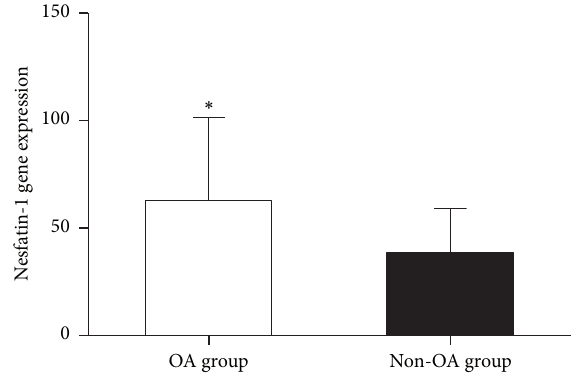
Figure 3: Nesfatin-1 levels in serum (S) and synovial fluid (SF). Serum nesfatin-1 levels were significantly higher in patients with OA than in controls ( ∗ 𝑃 < 0.05 ). In patients with OA, nesfatin-1 levels were lower in SF than in paired serum samples ( ∗∗ 𝑃 < 0.001 ).